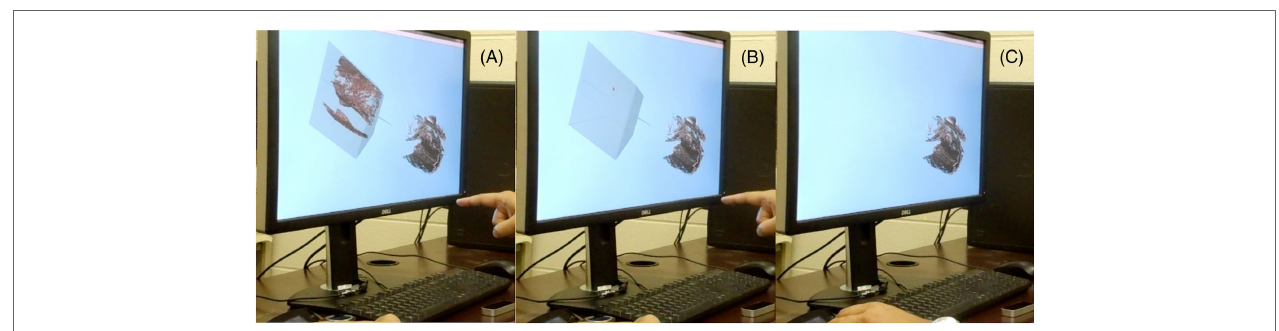
FigUre 4 | hiding a sub-volume – (a) point to select a sub-volume, (B) hit the escape key to hide, and (c) remove the tracked hand